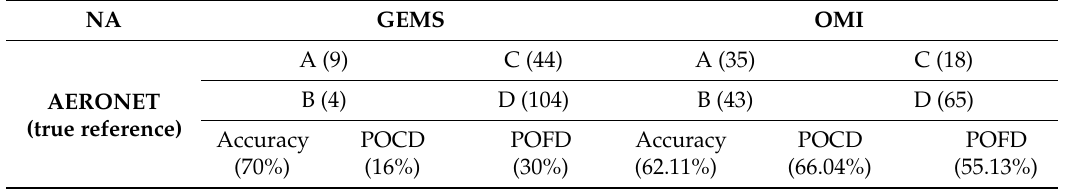
Table 4. Calculated accuracy, POCD, and POFD for NA detected GEMS aerosol